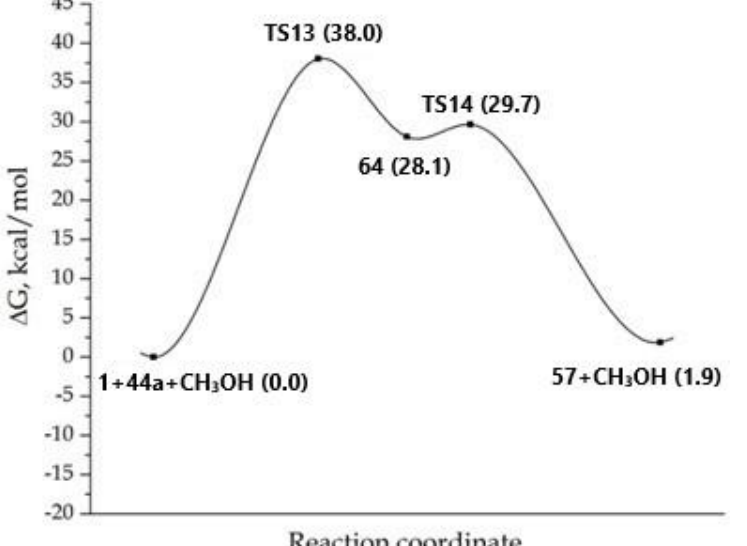
Figure 8. MEP for the trimolecular reaction concerning the formation of adduct 57 . The totalenergy of the starting reagents 1 , 44a and methanol was taken as the reference point. The methanol molecule facilitated the 1,5-proton transfer, being included in the eighth- center transition state ( TS14 ), performing the function of a bifunctional catalyst. As before, the process of the formation of structure 57 was